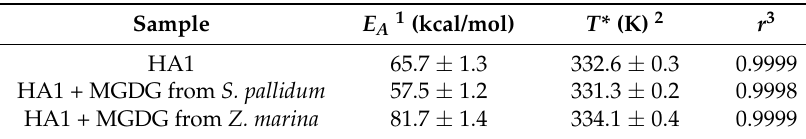
Figure 3. Temperature dependence of the excess molar heat capacity of the HA1 subunit of influenza A virus H1/N1 hemagglutinin alone (circles) and in the complex with monogalactosyldicylglycerol (MGDG) from Sargassum pallidum (squares) or Zostera marina (triangles) at a scan rate of 60 K h −1 in PBS, pH 7.4. Solid lines represent the best fit to each experimental curve using equation (2). Table 1. Arrhenius equation parameter estimates of the thermal denaturation of HA1 alone and in complexes with MGDGs from different marine macrophytes.